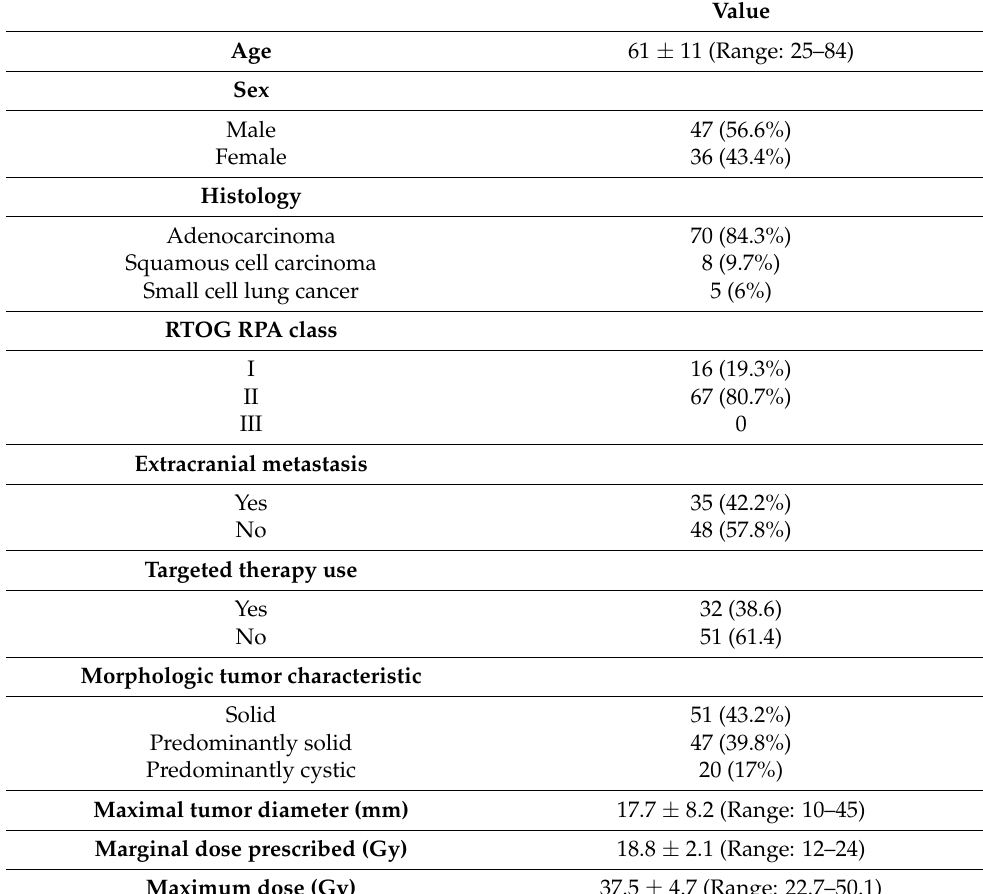
Table 1. Patient demographics and tumor